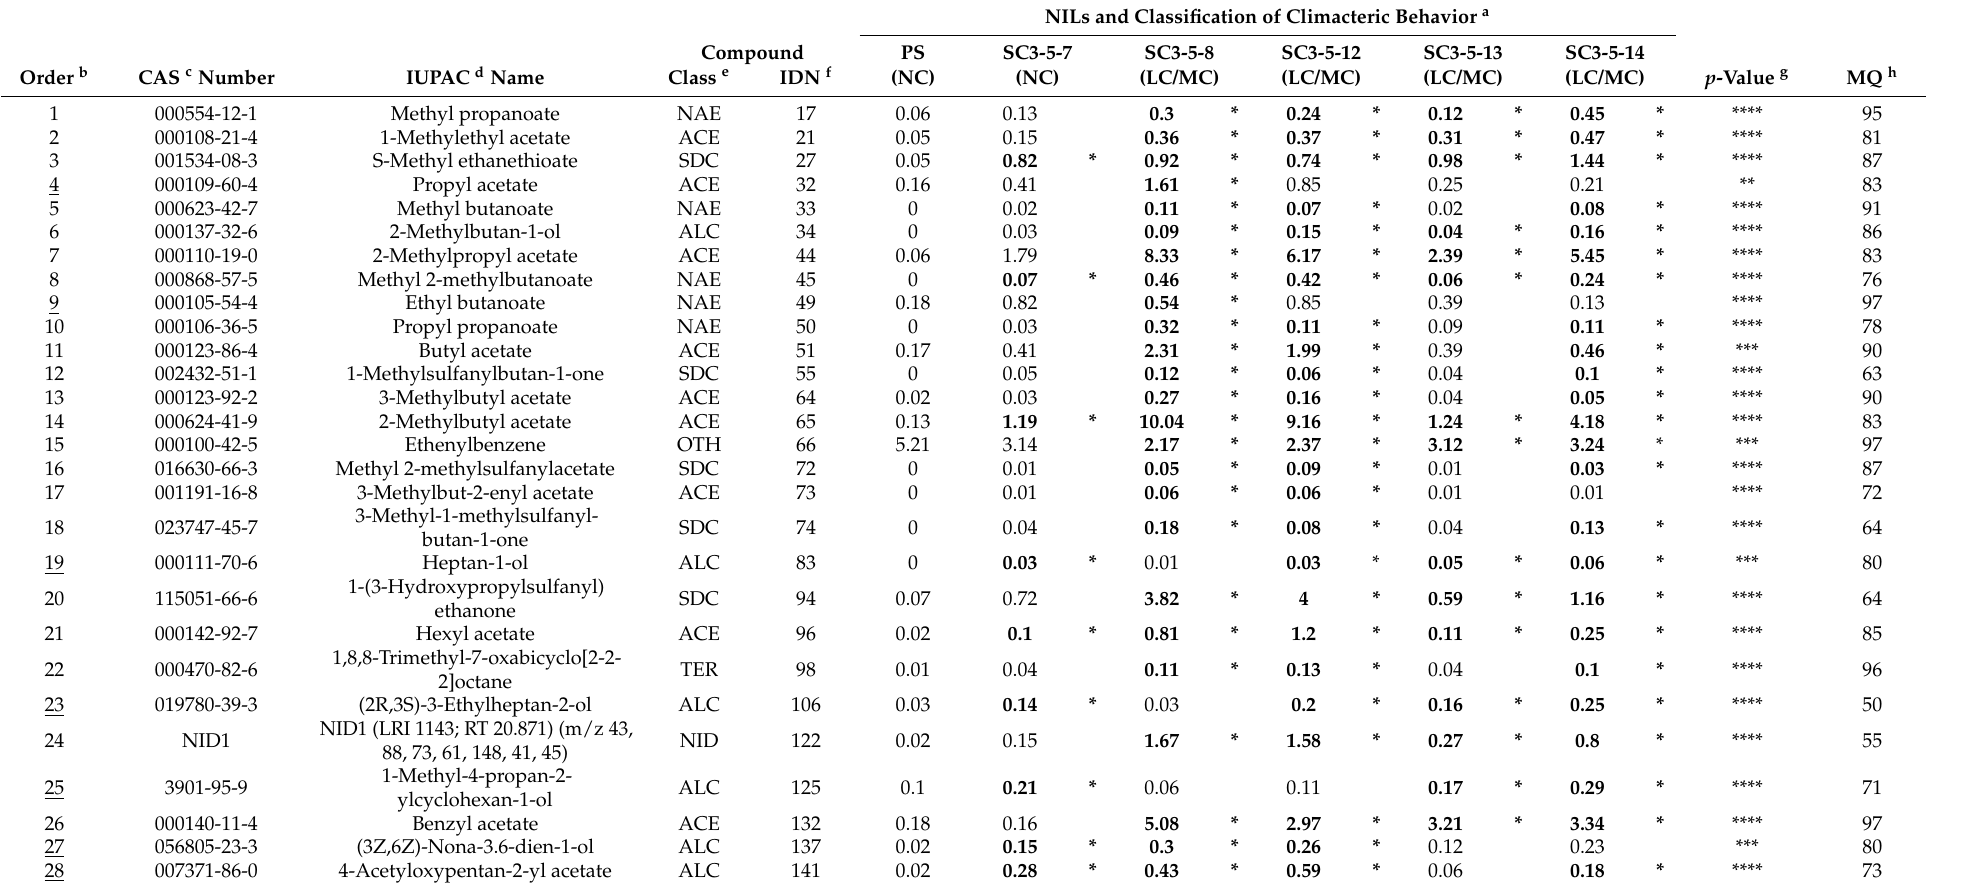
Table 2. Main fruit volatile compounds identified for QTL mapping in melon chromosome 3 using five Near-Isogenic Lines (NILs) with different physiological behavior (SC3-5-7, n = 5; SC3-5-8 and SC3-5-12, n = 7; SC3-5-13 and SC3-5-14, n = 9) and the parental control ‘Piel de Sapo’ (PS) ( n = 21). Volatile compounds were selected for significance of the univariate statistical criterion described. Data are the mean relative content in percentage with respect to the total of the probable aromatic volatile compounds identified. NIL means in bold followed by an asterisk were significantly different from the control PS mean according to one-way ANOVA with pedigree effect followed by a Dunnett test ( p = 0.05). *, **, ***, **** significance at p ≤ 0.05, 0.01, 0.001, and 0.0001,